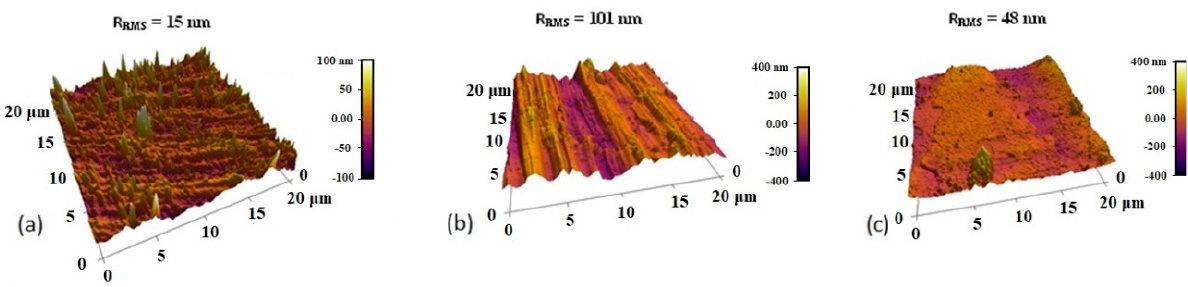
Figure 5. Three-dimensional AFM micrographs of the surface topography of the deposited DLC coatings on ( a ) untreated substrate; ( b ) treated substrate with a beam power of 1000 W; ( c ) treated substrate with a beam power of 1500